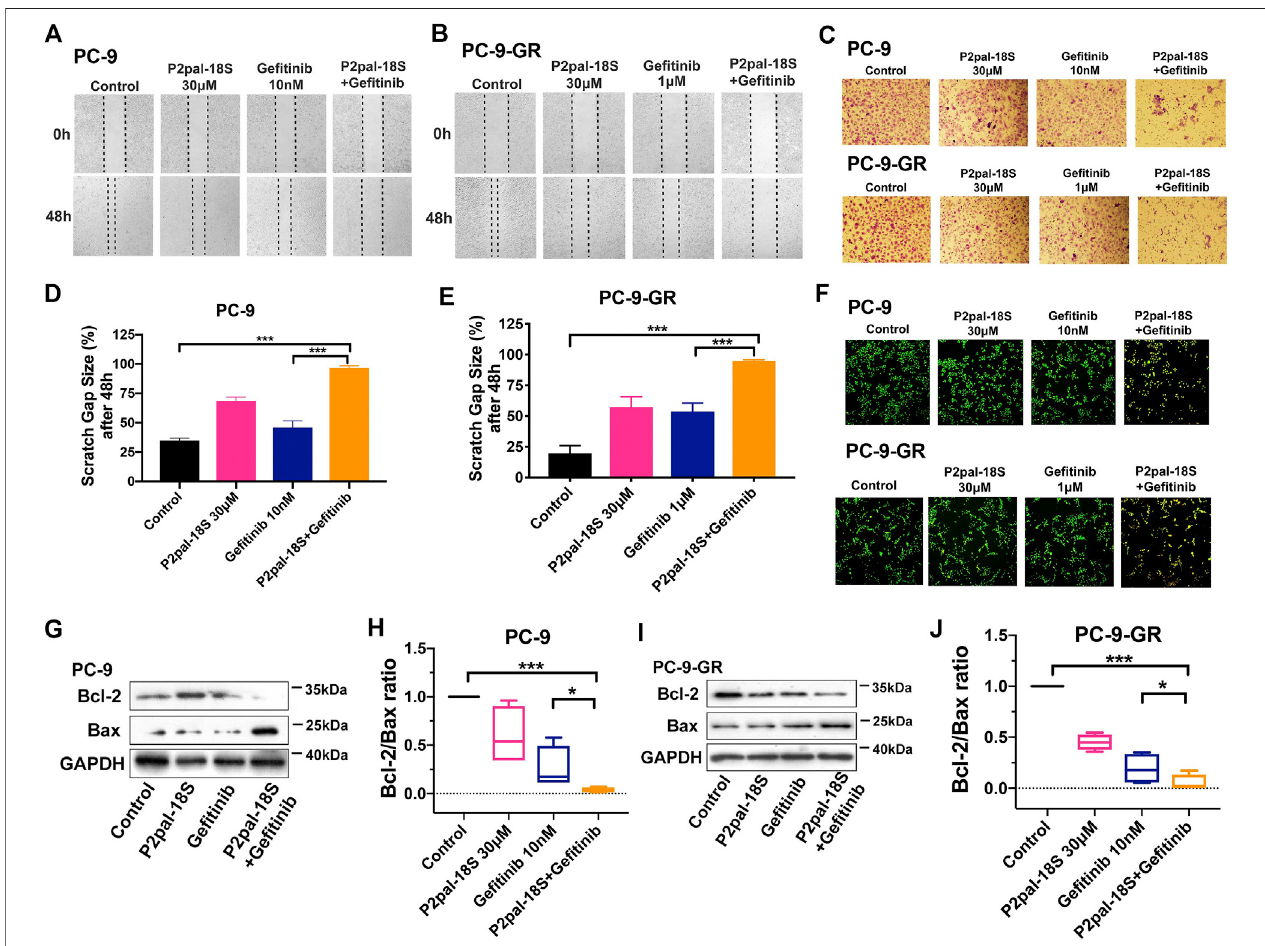
FIGURE 2 | PAR2 augmented ge fi tinib-mediated NSCLC cell migration and apoptosis in both PC-9 and PC-9-GR cells. (A-B) . P2pal-18S and ge fi tinib showed a synergic effect for attenuating migration in in-vitro scratch assay; (C) . P2pal-18S enhanced ge fi tinib to inhibit cell migration detected by a transwell platform; (D – E) . The quantitative analysis of scratch gap sizes was calculated for different treatments; (F) . P2pal-18S facilitated ge fi tinib-induced apoptosis by AO/EB staining; (G – J) . With treatmentofP2pal-18Sandge fi tinib,proteinexpressionsofBcl-2andBaxweredetectedbywesternblot (G,I) andtheratioofBcl-2andBaxwascalculated (H,J) . * p < 0.05, *** p <